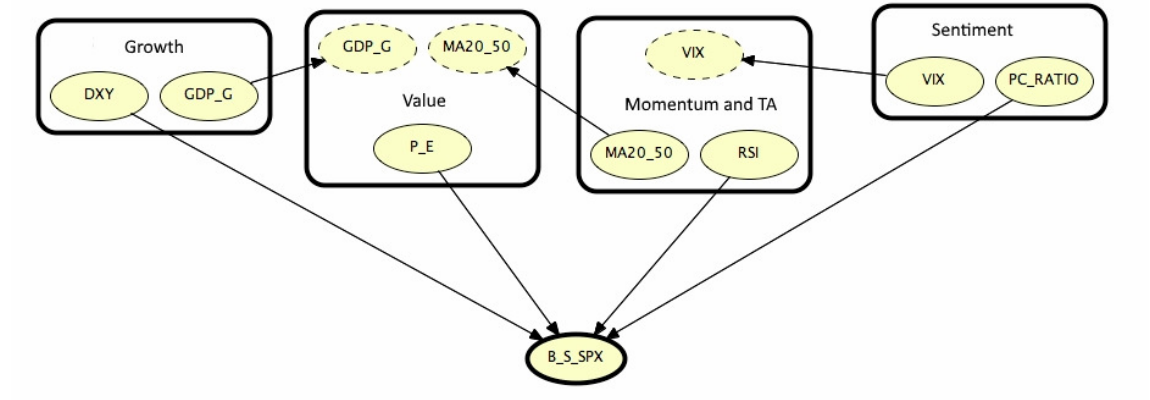
Figure 4. OOBN on the S&P 500 time series during the first